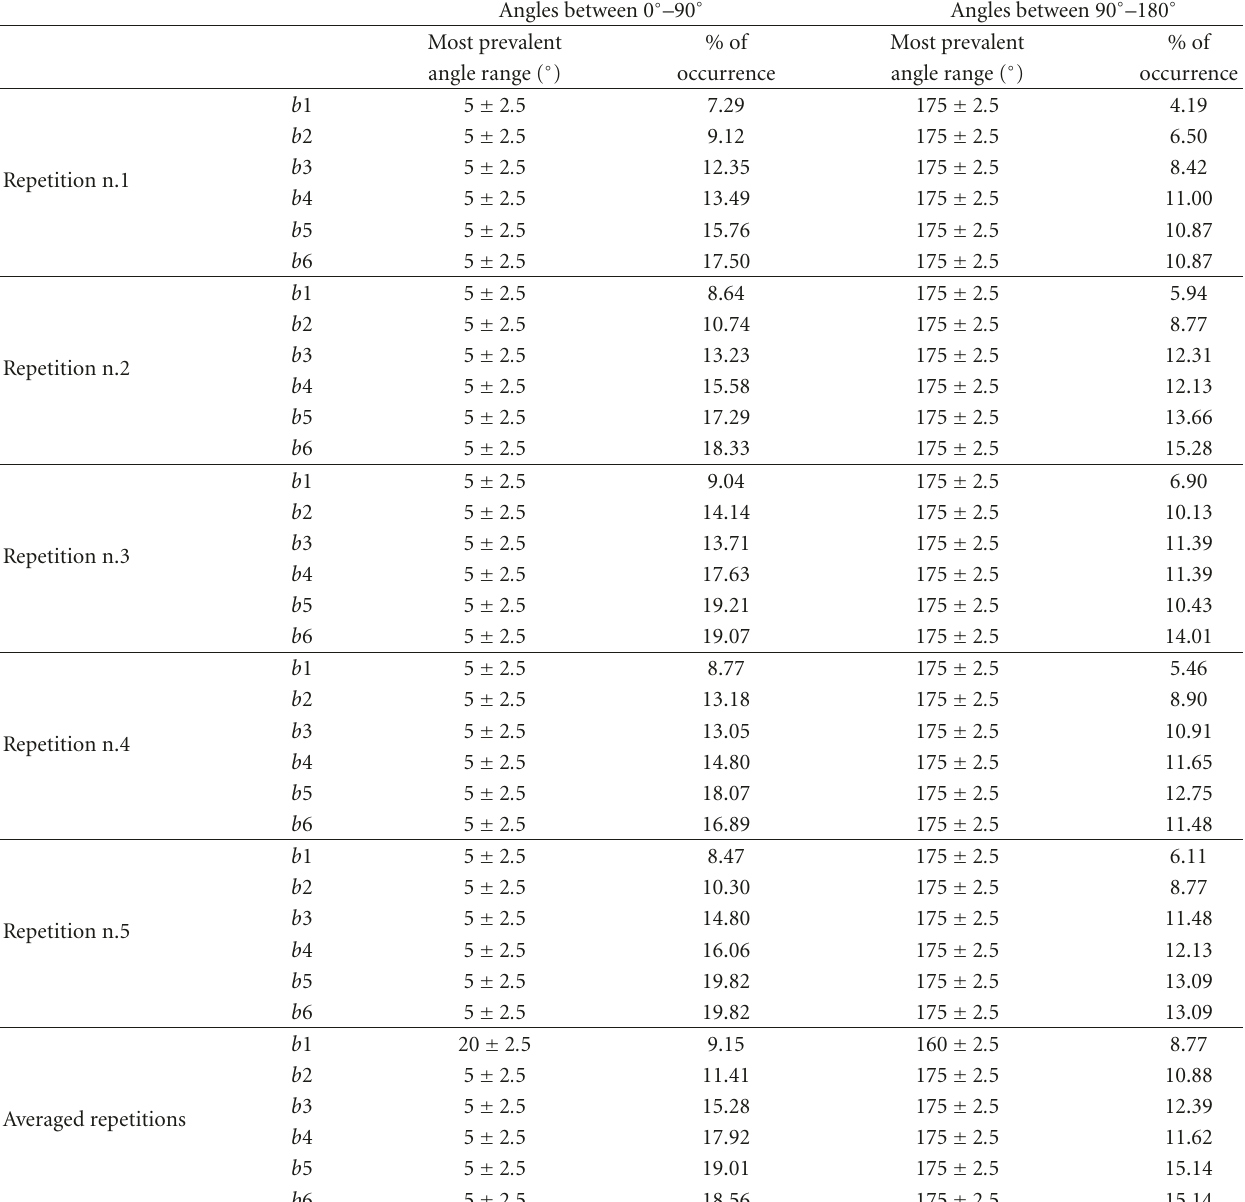
Table 1: Evaluation of the di ff erence in the eigenvector angles between each repetition and the average over all the repetitions for the central slice of the image. Angles between 0 ◦ –90 ◦ Angles between 90 ◦ –180 ◦ Most prevalent % of Most prevalent % of angle range ( ◦ ) occurrence angle range ( ◦ )